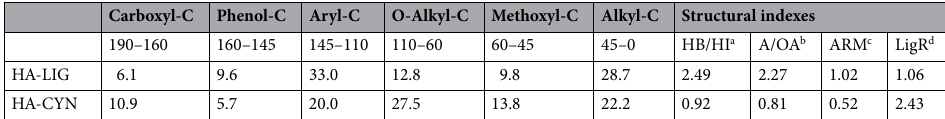
Table 2. Relative contribution (%) and structural indices calculated from spectral data of main C structures over chemical shift regions (ppm) of 13 C CPMAS-NMR spectra of HA-LIG and HA-CYN. a HB/ HI = hydrophobicity index = [Σ (0–45) + (110–160)/ Σ (45–60) + (60–110) + (160–190)]. b A/OA = alkyl/O- alkyl ratio (0–45)/(60–10). c ARM = aromaticity index [(110–160)/Σ (0–45) + (60–110)]. d LigR = Lignin ratio